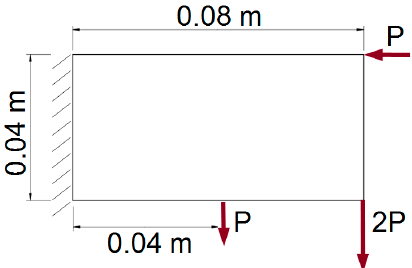
Figure 17. Initial structure with applied loads and supports, example 2.